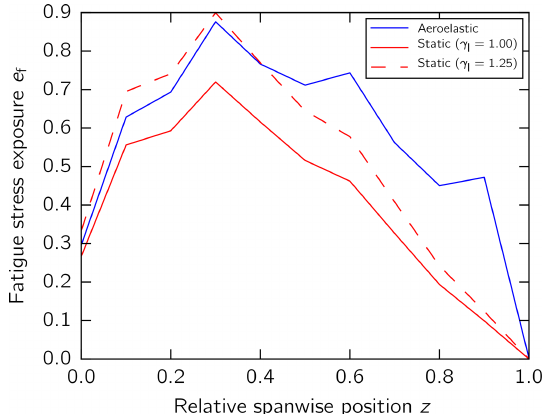
Figure 10. Fatigue stress exposure along the trailing-edge bond line obtained with the two simulations.